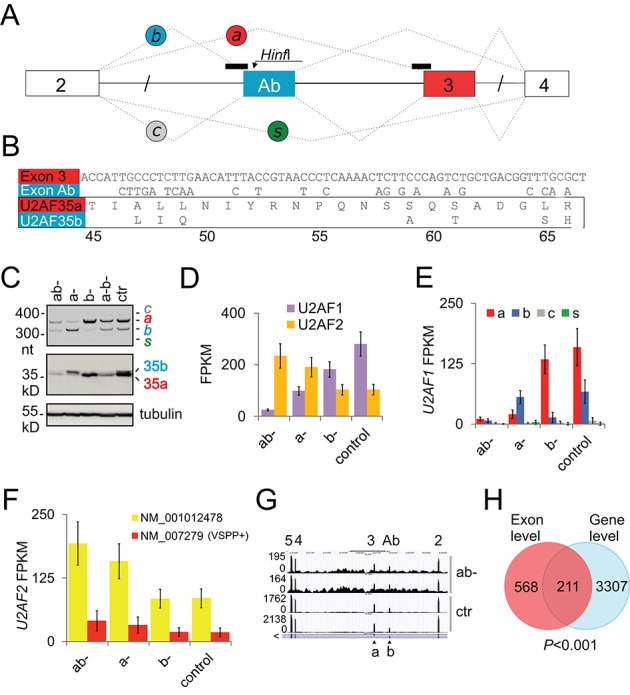
Genome-wide identification of U2AF(35)-dependent exons. (A) Alternative splicing of U2AF1 and location of SSOs. Exons are shown as boxes, introns as horizontal lines, SSOs as black rectangles across 3′ss and spliced products (a, b, c, s) as dotted lines. (B) Nucleotide (upper panel) and amino acid (lower panel) sequences of alternatively spliced U2AF1 exons. Amino acids are numbered at the bottom. (C) HinfI digested RT-PCR products showing the relative abundance of U2AF1 isoforms in depleted samples (upper panel) and immunoblot with antibodies against U2AF35 and tubulin (lower panels). ab-, depletion of both isoforms using siRNA U2AF35ab (30 nM); a-, depletion of U2AF35a (60 nM); b-, depletion of U2AF35b (60 nM); a-b-, depletion of U2AF35 using equimolar mixtures of isoform-specific siRNAs; siRNAs were as described (14,23). Ctr, a scrambled control. (D) Normalized expression of U2AF1 and U2AF2 genes in depleted cultures and controls. FPKM, fragments per kilobase of exon model per million reads. Error bars in panels D–F are 95% confidence intervals. U2AF1/U2AF2 ratios in ab-, a-, b- and control cultures were 0.09, 0.43, 1.47 and 2.25, respectively. (E) Normalized expression of U2AF1 isoforms. (F) Normalized expression of U2AF2 isoforms. Extra amino acids included in U2AF65 as a result of alternative GC 5′ss usage are in parentheses. (G) A genome browser view of exon Ab- and 3-containing isoforms in depleted cells (ab-) and controls (ctr). Exons are numbered at the top and corresponding isoforms are shown at the bottom. Browser views are in the native gene orientation throughout; the 5′>3′ transcriptional orientation is denoted by the > sign. (H) Significant sharing of genes identified by DEXSeq (exon-level) and Cufflinks (gene-level) as differentially expressed in ab- cultures versus controls.